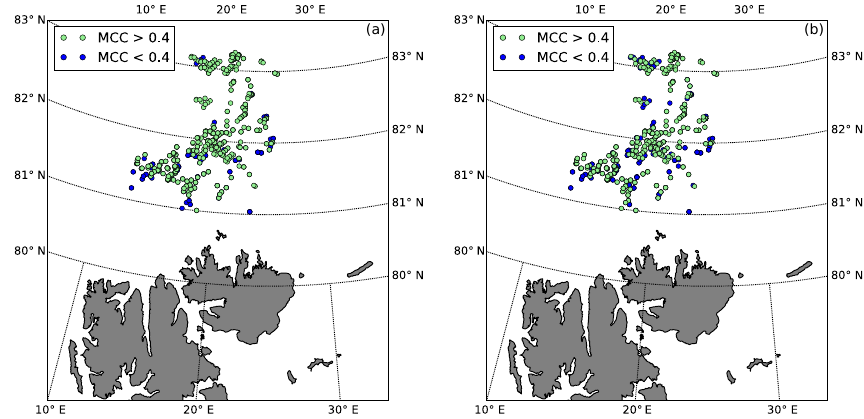
Figure 9. Considered buoy locations from the N-ICE2015 expedition that were used for comparison with algorithm results. Green and blue colours indicate start locations (on SAR 1 ) to which the algorithm provided vectors with a MCC value above and below 0.4 using (a) HV and (b) HH